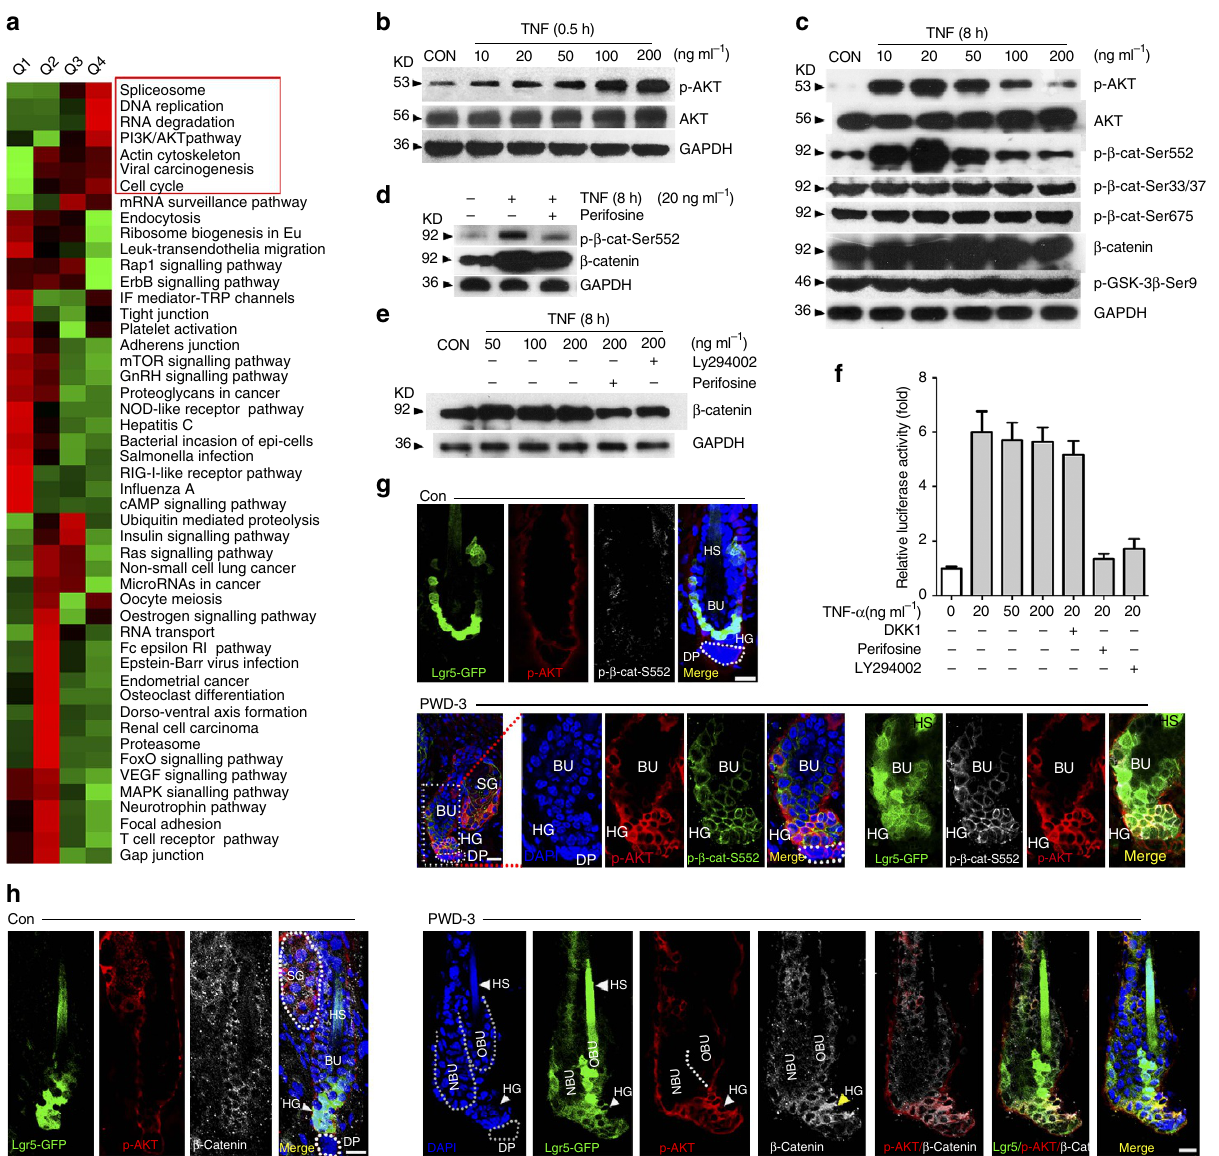
Figure 4 | TNF activates the PI3K/AKT pathway in HF stem cells. ( a ) Using TMT labelling and affinity enrichment followed by high-resolution LC–MS/MS and quantitative phosphor-proteomics, functional enrichment-based cluster analysis identified up-regulated signals in cultured epidermal stem cells after TNF- a treatment. ( b ) Western blot analysis of p-AKT (at Serine 473) and total AKT in cultured murine epidermal stem cells in the presence of different concentrations of TNF- a for 0.5h. For all western blot analysis, data are representative of 3–5 independent experiments. ( c ) TNF- a treatment (8h) resulted in no obvious changes in p-GSK-3 b (ser9) and p- b -catenin (Ser33/37/Thr45, Ser675) but significantly increased the level of p- b -catenin (Ser552), which also showed in a TNF-dose-dependent manner, quite similar to p-AKT. ( d ) Perifosine diminished p- b -catenin (Ser552) levels that were elevated by TNF- a in cultured epidermal stem cells. ( e ) Western blot analysis indicated that TNF- a increased the level of b -catenin, and the effect was attenuated by Perifosine or LY294002. ( f ) TCF/LEF Dual-luciferase reporter analysis showed the relative transcription activity in differently treated groups. ( g ) At PWD-3, both p-AKT (Ser473) and p- b -catenin (Ser552) were detected in the wound adjacent to Lgr5 þ hair follicle stem cells, and the p-AKT (Ser473) and p- b -catenin (Ser552) were highly co-localized. ( h ) At PWD-3, accumulated b -catenin was detected in the wound adjacent to Lgr5 þ hair follicle stem cells, and the accumulated b -catenin was highly co-localized with p-AKT (Ser473). Scale bars, 30 m m.